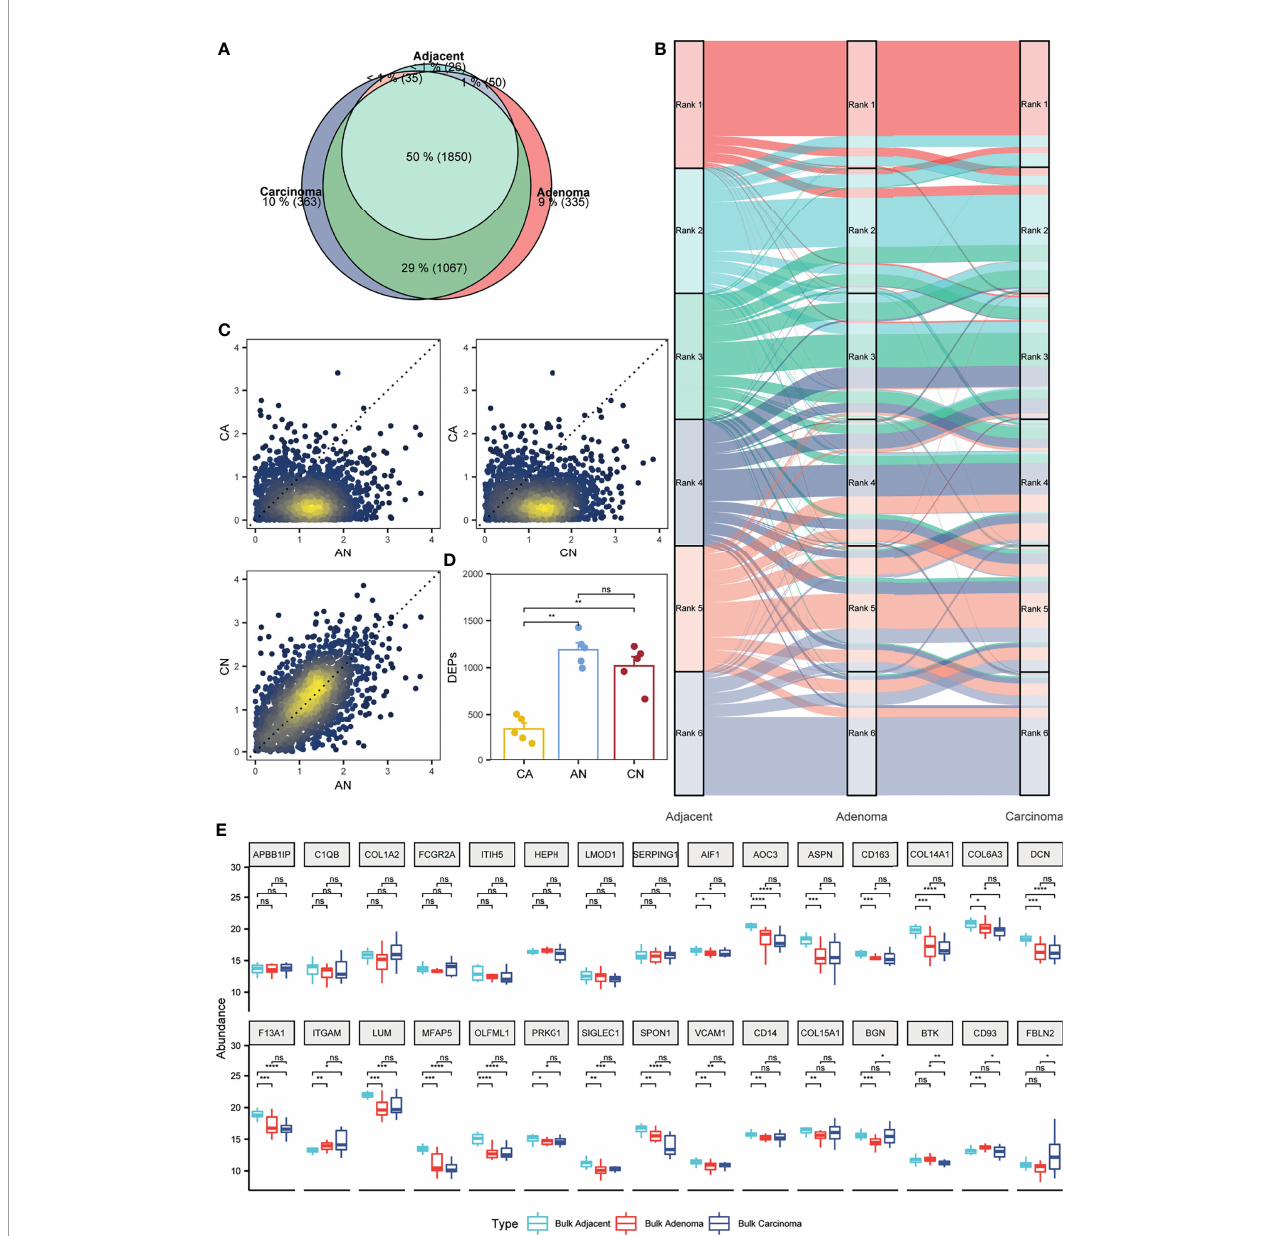
FIGURE 3 | Appraisal of the stromal proteomes in the adjacent, adenoma, and carcinoma tissues. (A) Overlap analysis to the stromal proteins identi fi ed in the adjacent, adenoma, and carcinoma tissues. (B) Comparison of the abundance patterns of stromal proteomes among the adjacent, adenoma, and carcinoma tissues using the alluvium plot. Each stromal proteome in a tissue is ranked at six abundance groups. (C) Comparison of the abundance ratios of stromal proteins that were generated by the division of the abundance of overlapped proteins in a tissue to that in another tissue, such as adenoma versus adjacent (AN), carcinoma versus adenoma (CA), and carcinoma versus adjacent (CN). (D) Statistical evaluation toward the stromal DEPs of AN, CA, and CN using Wilcoxon test. The signs of ** and ns represent a signi fi cance with p < 0.01 and nonsigni fi cance. (E) Statistical evaluation toward the stromal biomarkers of ESTIMATE in the three bulk tissues, adjacent, adenoma, and carcinoma using Wilcoxon test. The signs of *, **, ***, and **** represent a signi fi cance with p < 0.05, p < 0.01, p < 0.001, and p < 0.0001, respectively, and ns, represents nonsigni fi